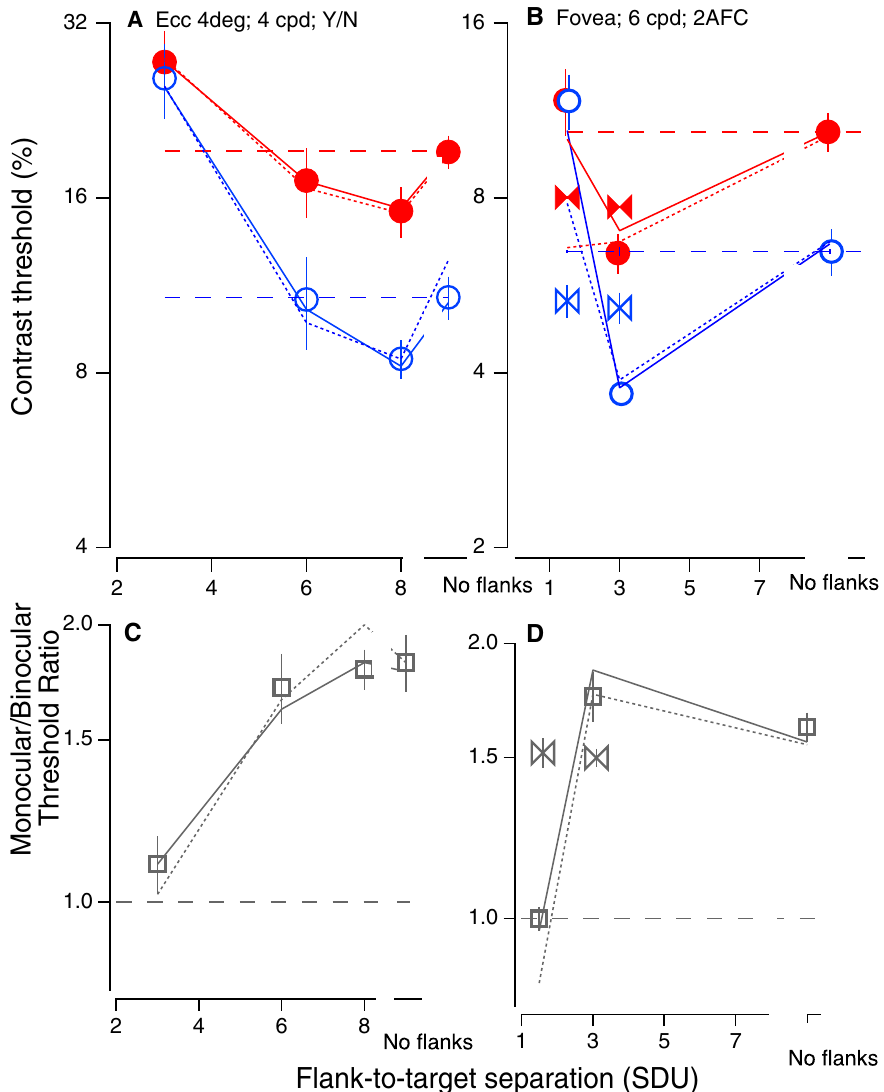
Figure 2. Contrast detection. Contrast thresholds for binocular (blue) and monocular (red) viewing as a function of flank distance ( A ) at eccentricity of 4°, with a different spatial frequency (SF 4 cpd) using a different psychophysical paradigm (Y/N), with flank contrast = 9.5 × threshold (symbols show the mean ± 1se of 7 observers). Dashed lines show the unflanked thresholds. ( B ) Foveal thresholds (eccentricity of 0°, SF 6 cpd, 2AFC, symbols show the mean ± 1se of 5 observers) with flank contrast = 6 × threshold. The solid lines are fits of the GUMI model and the dotted lines are fits of the aGUM model. ( C , D ) Binocular summation factor (monocular/binocular threshold ratio) from ( A ) and ( B ) respectively. Dashed lines indicate no